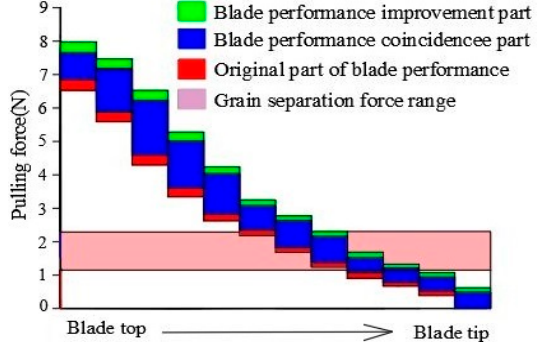
Figure 16. Comparison of tensile properties at the top of the blades.